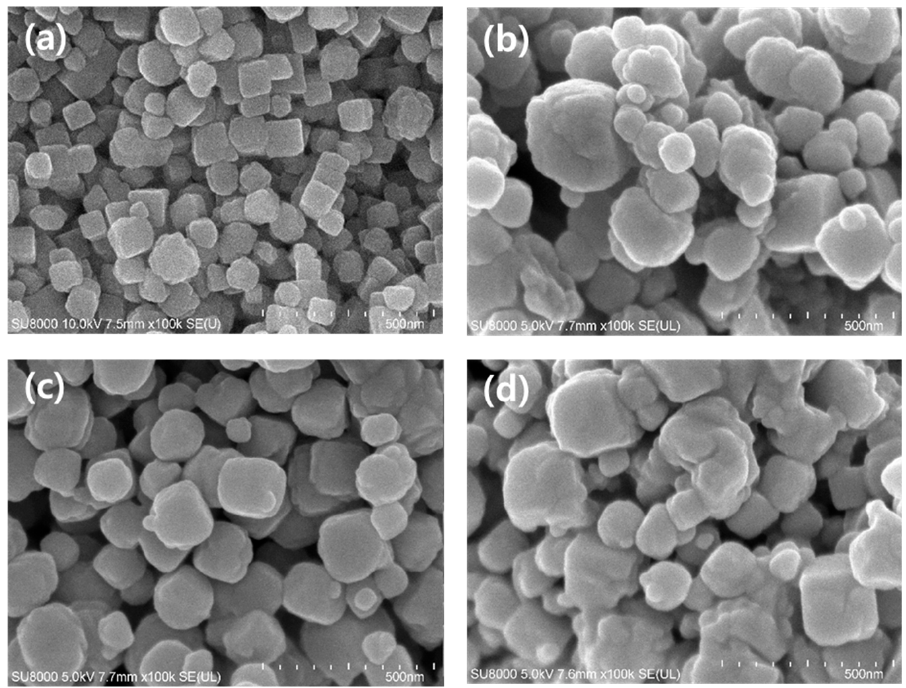
Figure 1. SEM images of ( a ) pure ZHS, ( b ) ALP-ZHS (1:5), ( c ) ALP-ZHS (1:1), and ( d ) ALP-ZHS (2:1) composites prepared at 50 °C for 1.5 h (magnification: ×100,000).